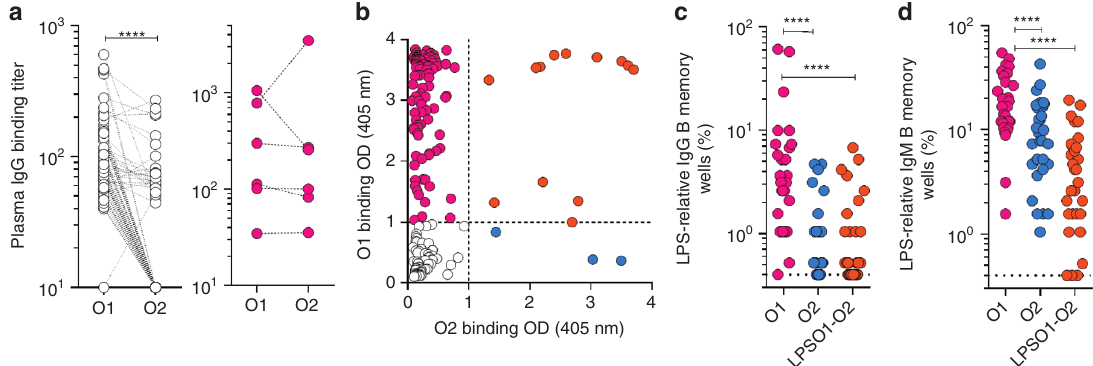
Fig. 2 Analysis of the human antibody response to K. pneumoniae O1 and O2 LPS. a O1 and O2-speci fi c IgG antibodies were measured by ELISA in plasma derived from 103 healthy donors (left panel) and 6 ICU patients (right panel) diagnosed with O2 K. pneumoniae infection. Shown are the endpoint titers based on serial dilutions. Lines between data points indicate data acquired from the same sample. b – d Analysis of antigen-speci fi c repertoires (AMBRA, antigen-speci fi c memory B cell repertoire analysis) from tonsillar IgG and IgM memory B cells of 33 donors (30 of the 33 were available for IgM